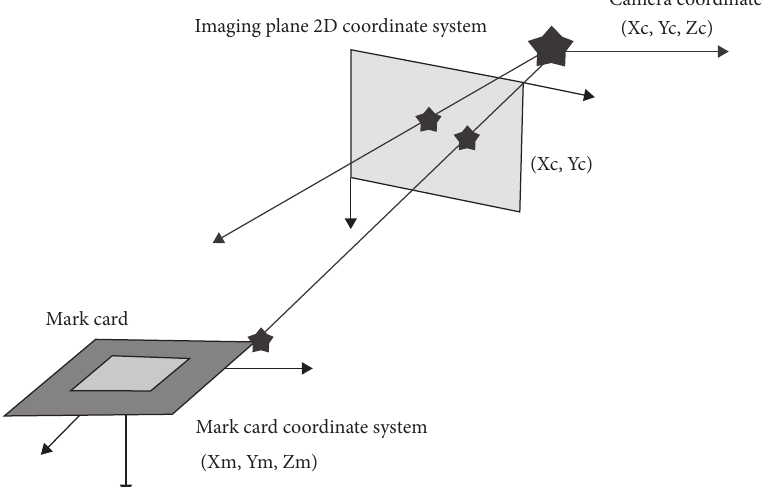
Figure 5: Relationship between the mark card coordinate system and the camera coordinate